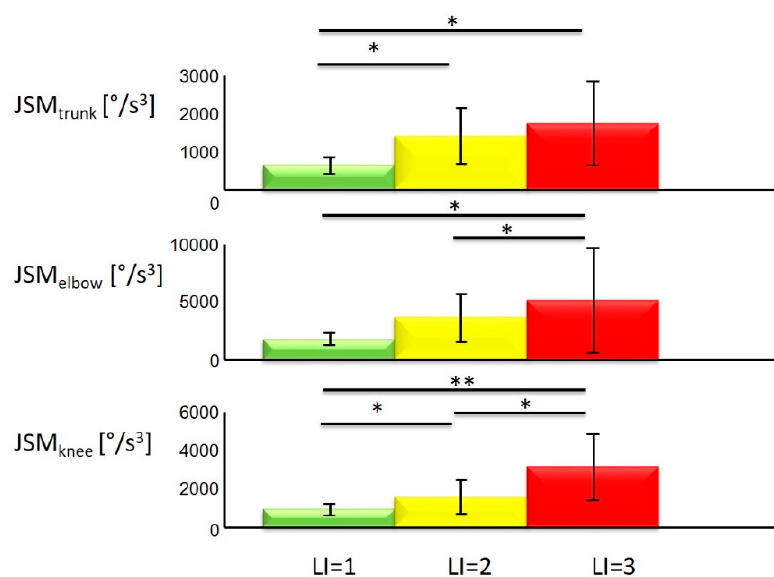
Figure 2. Jerk square mean (JSM) values. Mean and standard deviation values of the JSM values evaluated considering angles of trunk, elbow and knee while performing manual material lifting tasks in the three different conditions (LI = 1, LI = 2 and LI = 3) and statistical significance (* means p- value < 0.05; ** means p -value < 0.001).